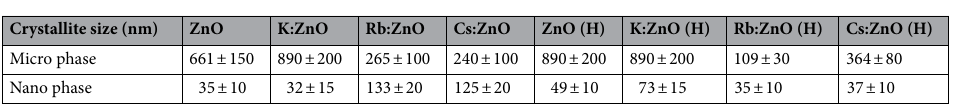
Table 1. Crystallite size information.